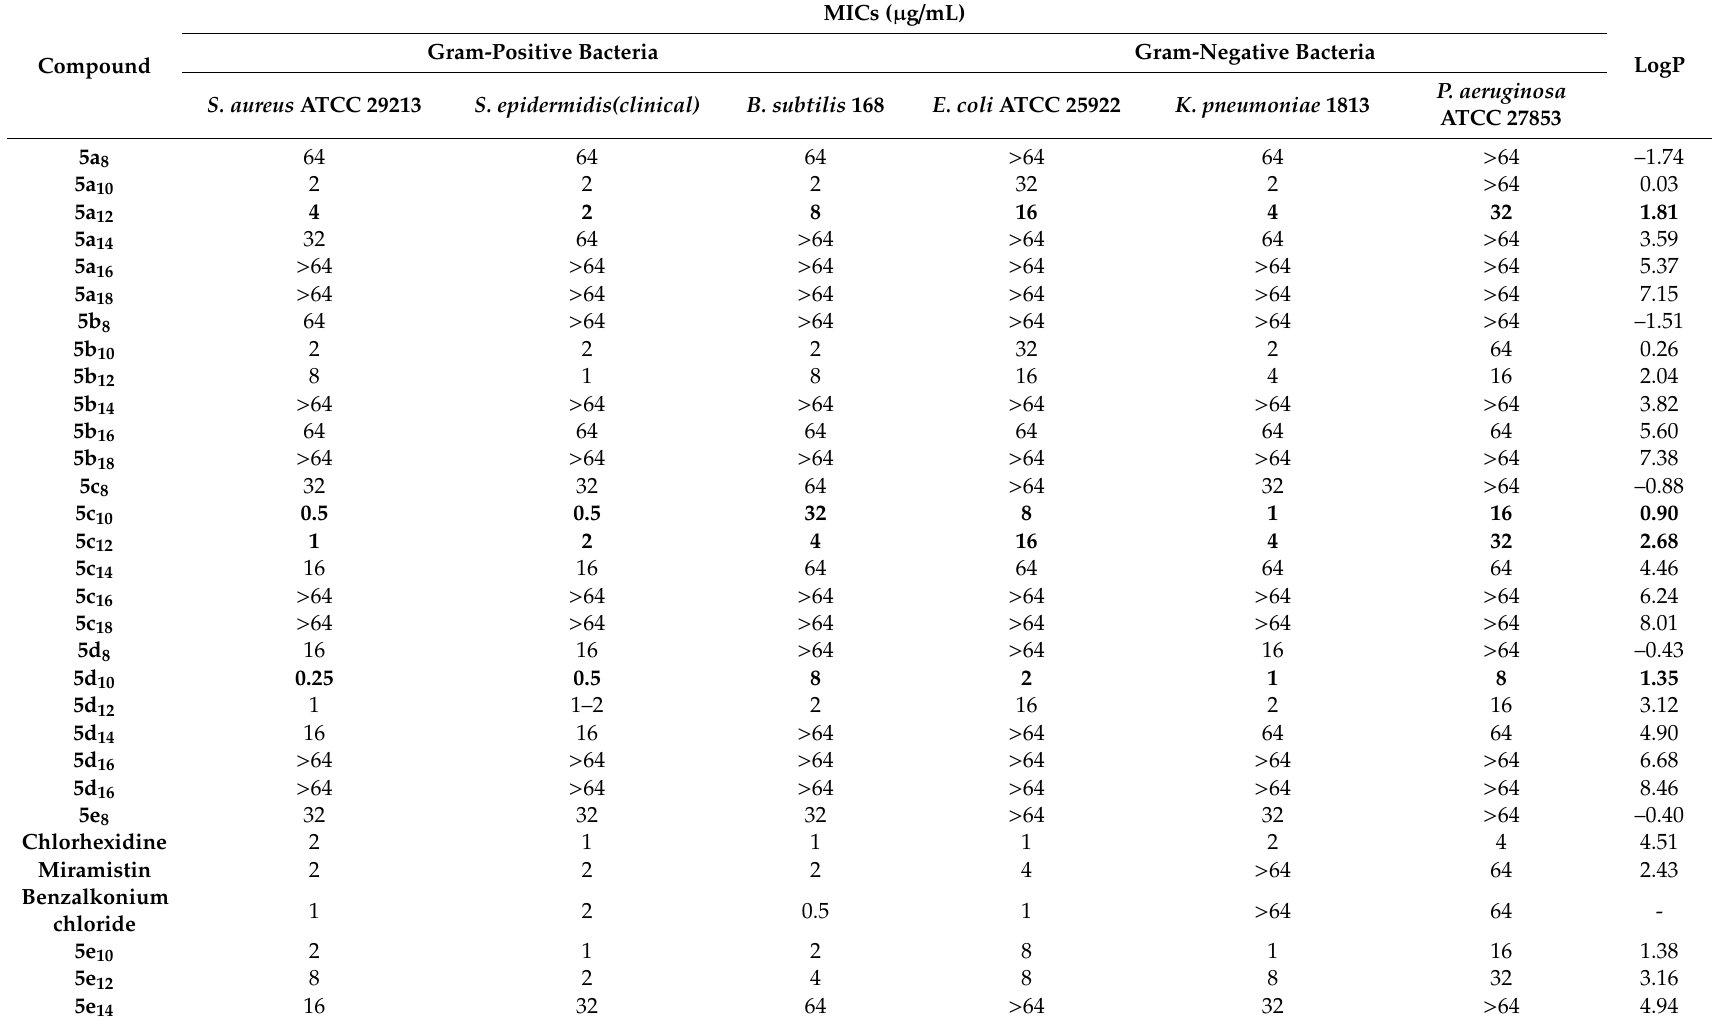
Table 1. In vitro antibacterial activity of novel bis-ammonium salts of pyridoxine a